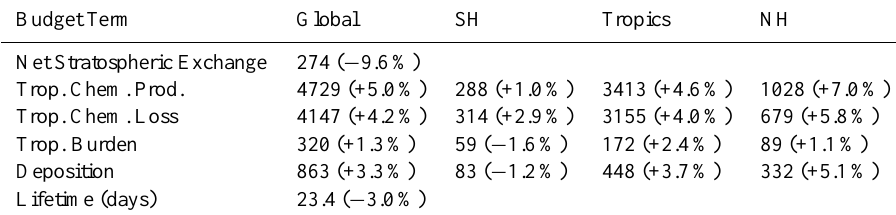
Table 2. The tropospheric chemical budget for O 3 given inTgO 3 yr − 1 during 2006 when applying the MBA. The relative percentage differences are also shown ((MBA-BA)/BA × 100). The contribution to each term from the SH extra-tropics/tropics/NH extra-tropics